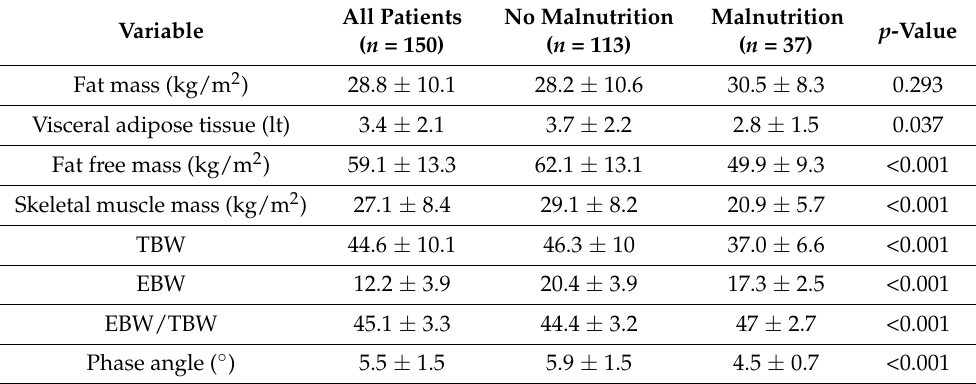
Table 2. Body composition data obtained by bioimpedance analysis in the study patients.